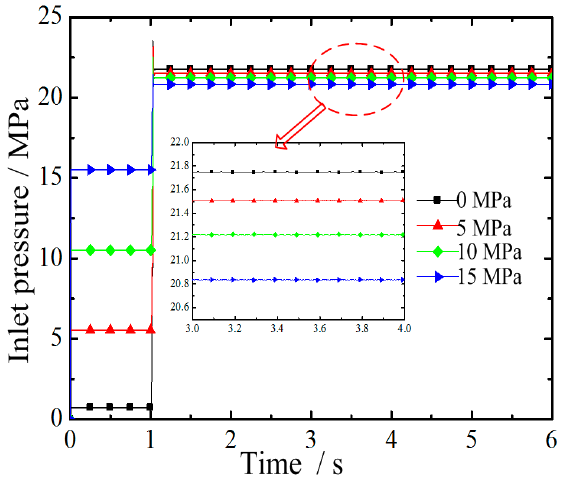
Figure 9. Influence of the outlet pressure of the PRV on the characteristics of the PRV.